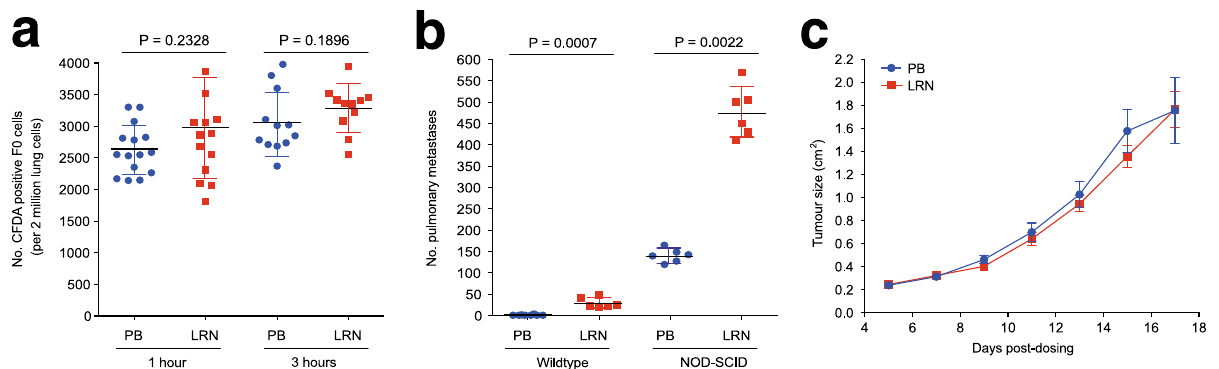
Fig. 3 Investigation of the mechanism of action of LRRN4CL. a The number of CFDA-positive B16-F0 cells present in the lung (per 2 million lung cells counted) after either 1- or 3-h post-tail vein dosing. The cells were stably transfected with a vector carrying mouse Lrrn4cl cDNA (LRN) or an empty vector (PB), and then labelled with the fl uorescent tracker dye, CFDA. Each symbol represents a mouse, the bars represent mean ± SD, and statistics were performed using a Mann – Whitney t test. b The number of metastatic colonies in the lungs of either wildtype or immunode fi cient (NOD-SCID) mice 10 days after being tail vein dosed with B16-F0 cells that have been stably transfected with a vector carrying mouse Lrrn4cl cDNA (LRN) or an empty vector (PB). Each symbol represents a mouse, the bars represent mean ± SD, two independent experiments were performed (representative data from one experiment is shown) and statistics were performed using a Mann – Whitney t test. c The growth of B16-F0 cells that have been stably transfected with a vector carrying mouse Lrrn4cl cDNA (LRN) or an empty vector (PB) after subcutaneous administration into the fl ank of wildtype mice. The data are shown as mean ± SEM with n = 8 – 9 mice per cell line per experiment. Two independent experiments were performed (representative data from one experiment is